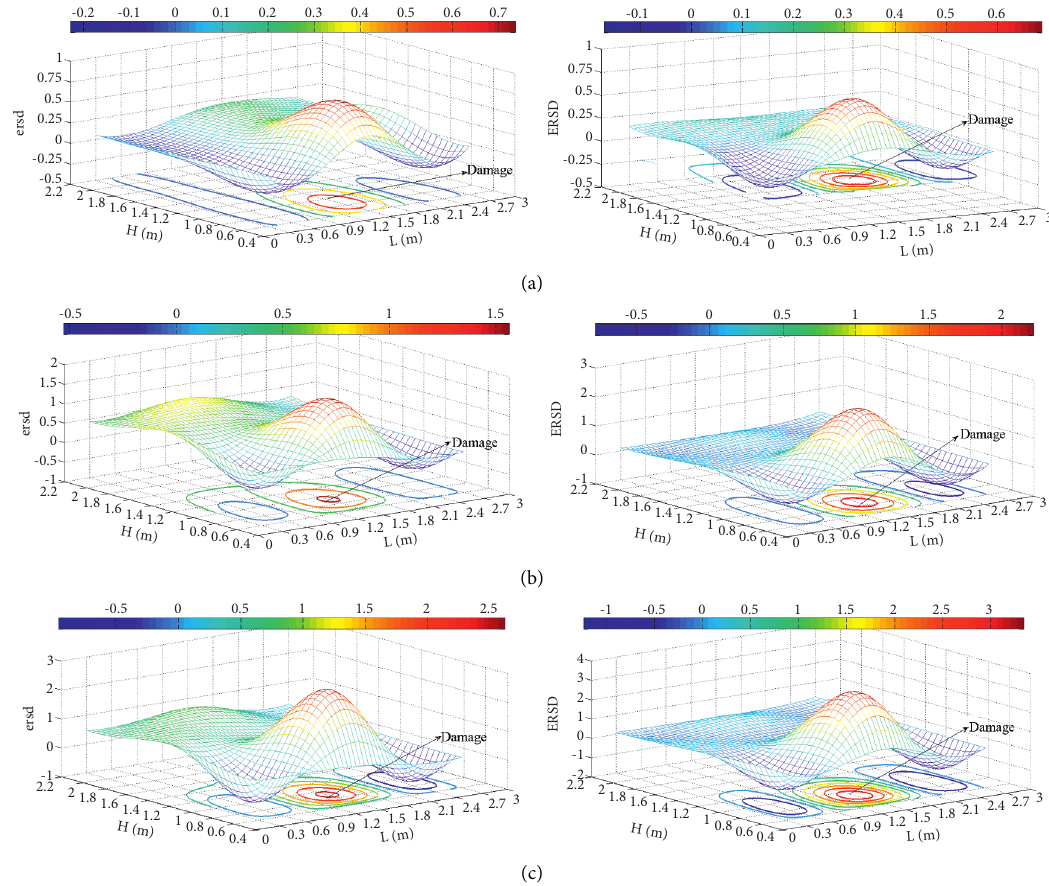
Figure 9: Trend surface of the damage index (the second time test at excitation point I). (a)Case 3. (b) Case 6. (c) Case